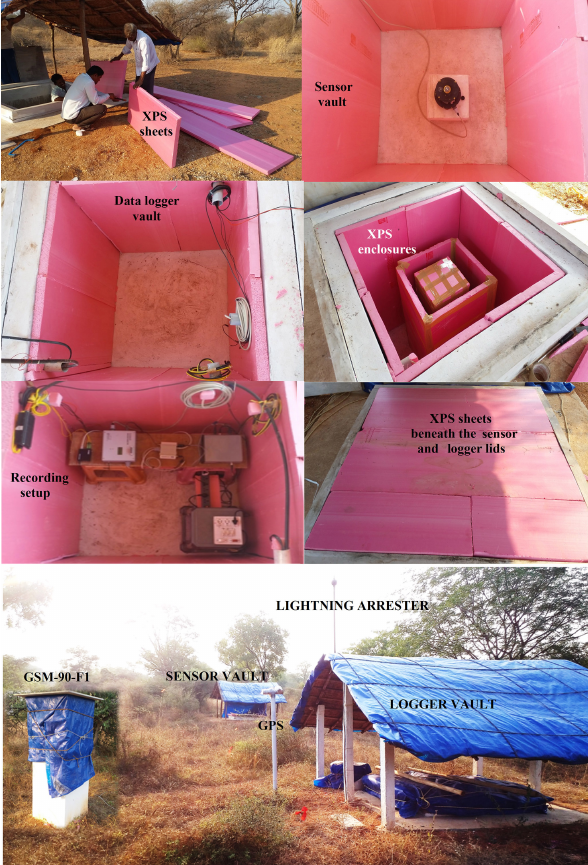
Figure 2. Thermally insulated new variometer (NV) vaults using extruded polystyrene (XPS) foam sheets and sheds of environmen- tally friendly natural